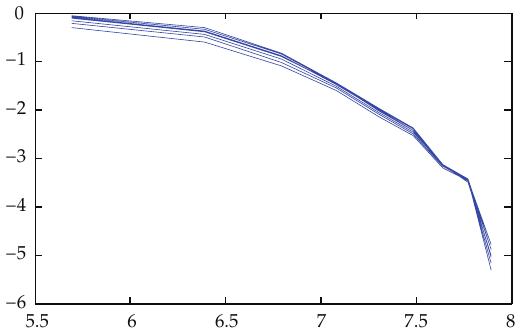
Figure 7: The fitting chart of Chinese medicine group for NIHSS baseline fractal m (cid:8) 2.